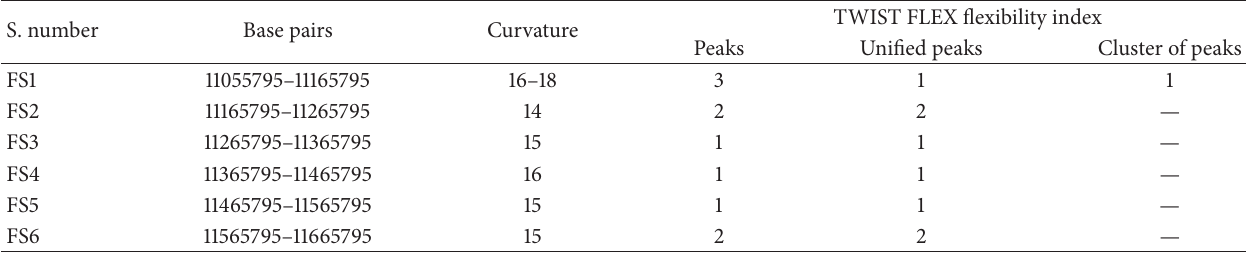
Table 1: Flexibility analysis of FRA11A sequence.